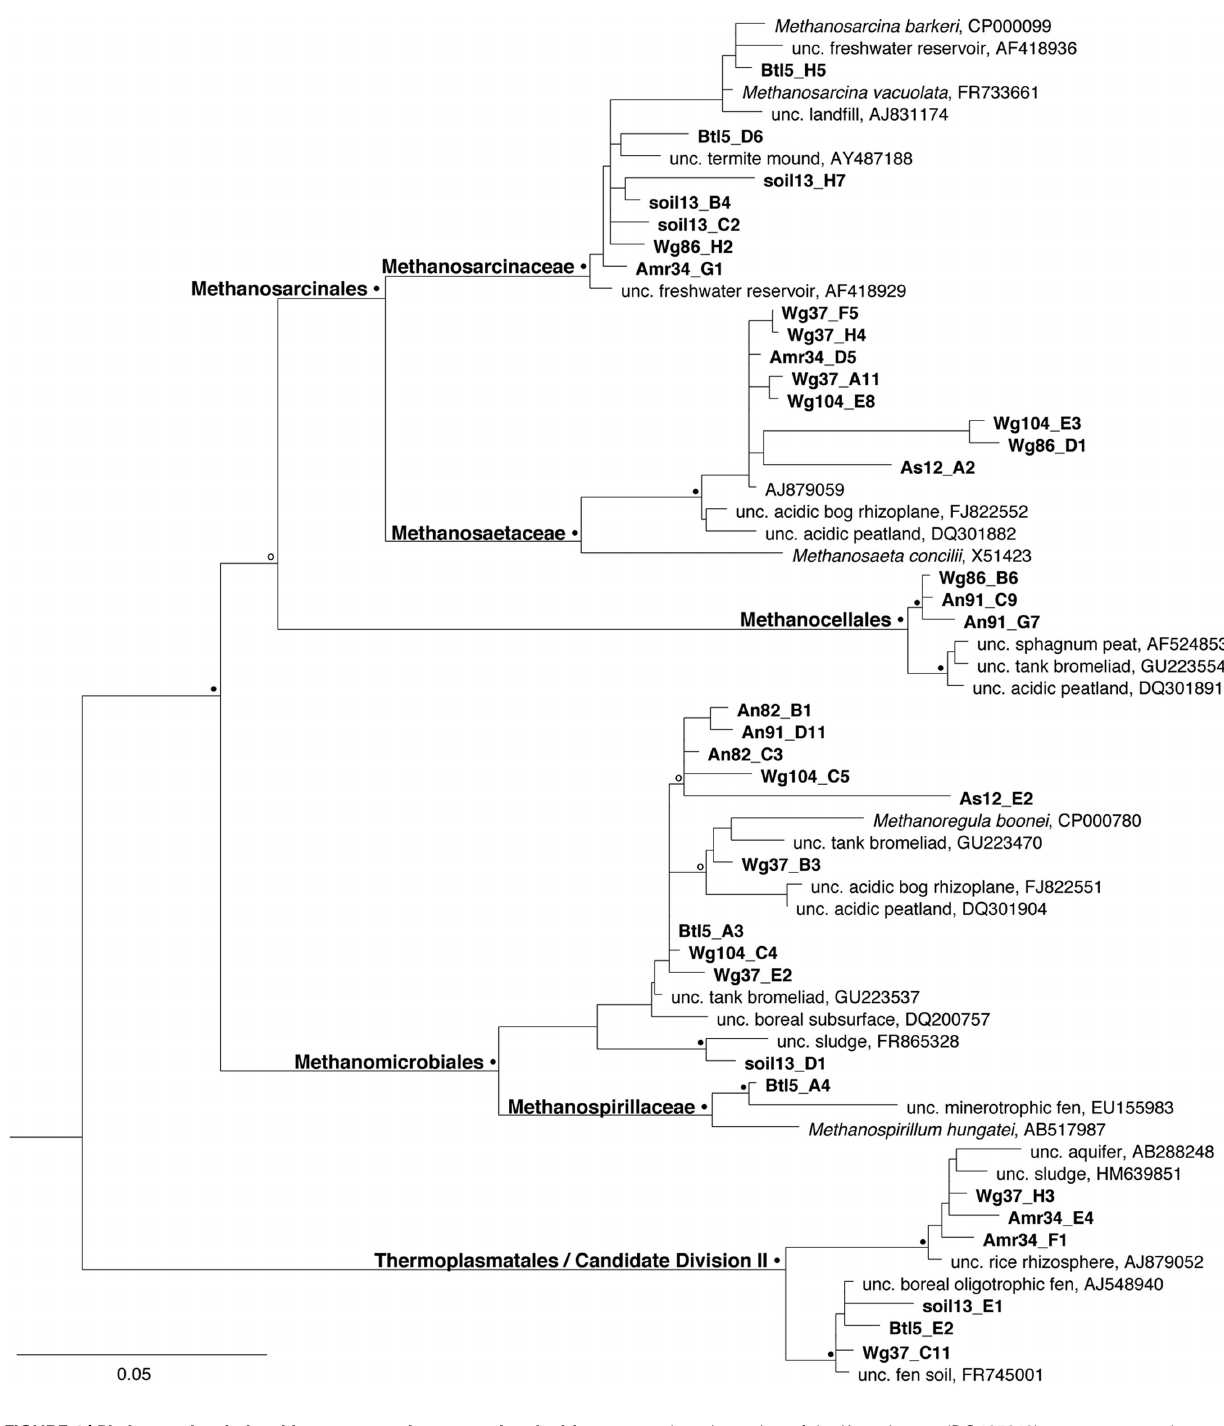
FIGURE 4 | Phylogenetic relationships among archaea associated with Costa Rican bromeliads, a nearby soil sample, and an artificial catchment, relative to selected cultured and environmental sequences in public databases. Relationships are based on sequence divergence within the 16S rRNA gene, with emphasis on methanogenic archaea, as well as those related to theThermoplasmatales/Candidate Division II, and an